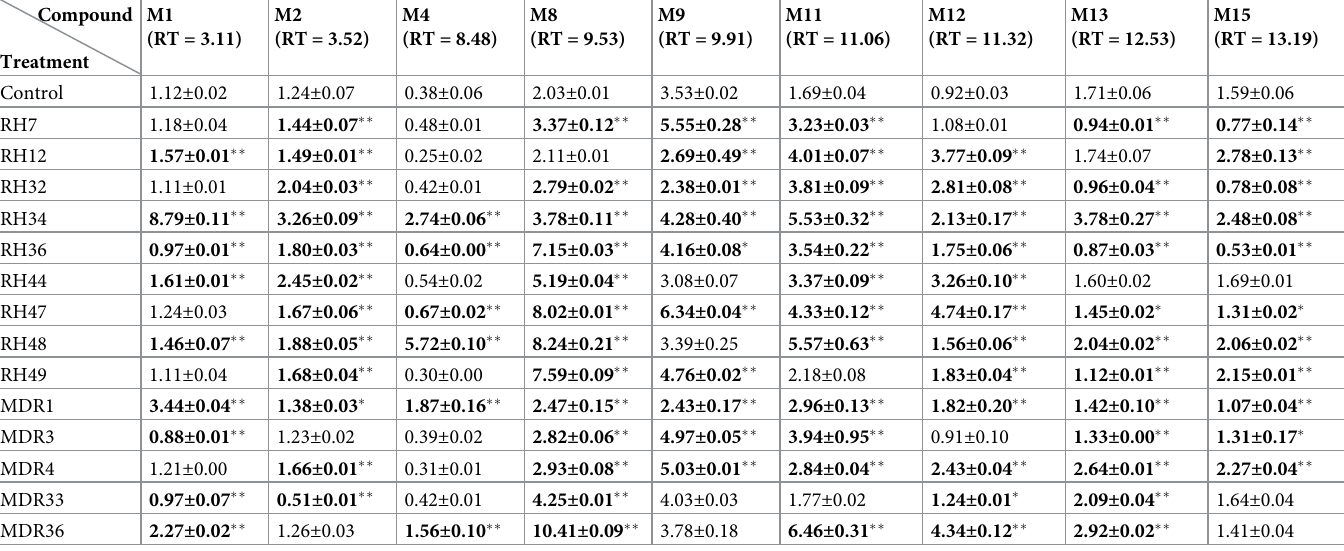
Values were indicated as ‘mean ± standard errors’ with different significances marked as‘ � ’ or ‘ �� ’, compared to the control. � : significant difference at 5%, and �� : significant difference at 1% (Tukey’s Test).